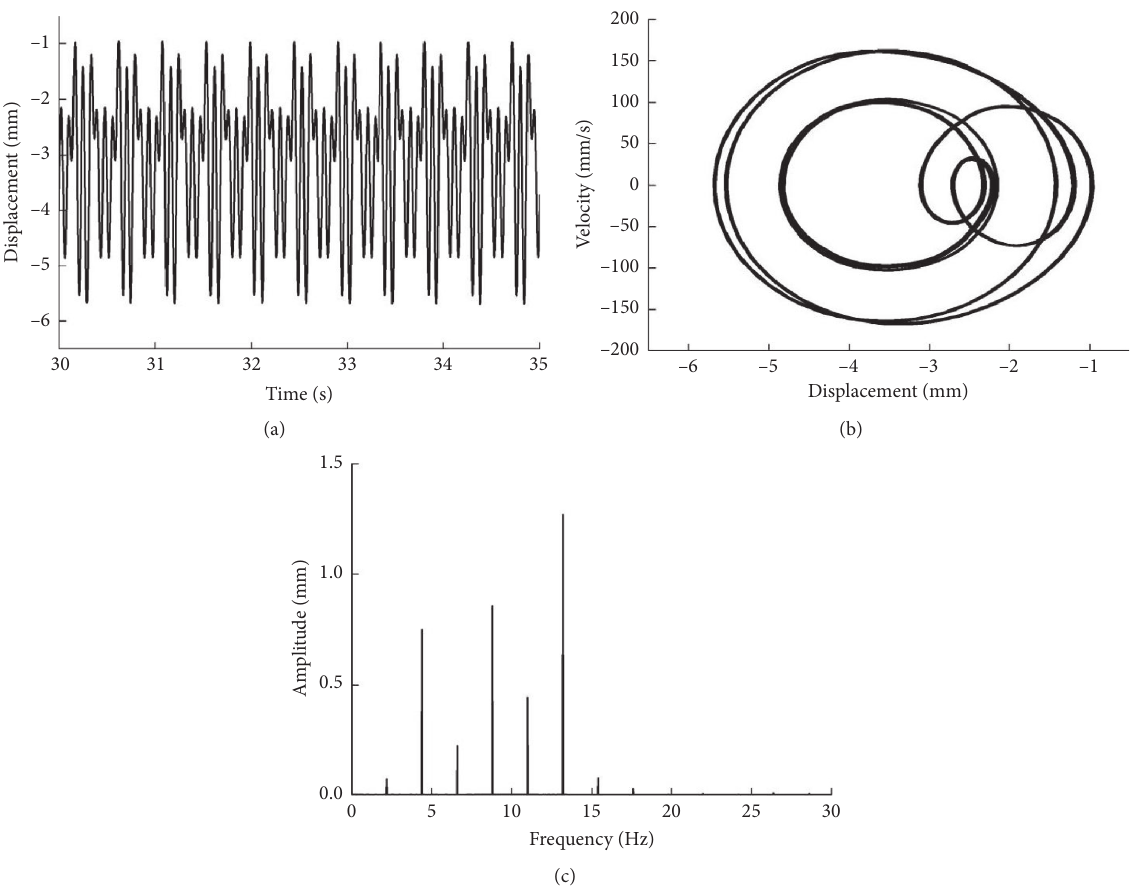
Figure 21: Multiperiod motion of the system is obtained for the external excitation frequency Ω � 13 . 2 Hz: (a) waveform; (b) phase portrait; (c) amplitude